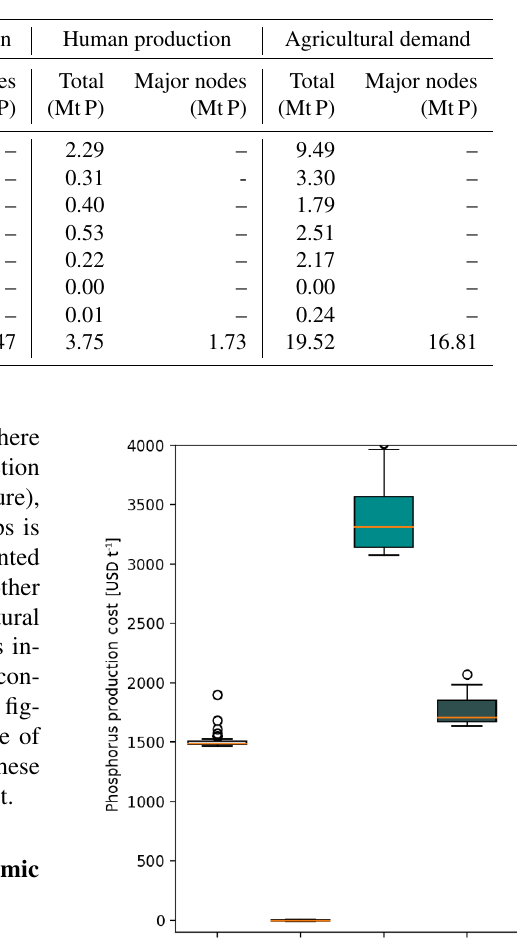
Table 1. Approximate continental phosphorus budgets associated with maps. The “total” values represent an estimation of recovering all phosphorus on the continent, while the “major nodes” values represents that which can be recovered at sites of high potential only.